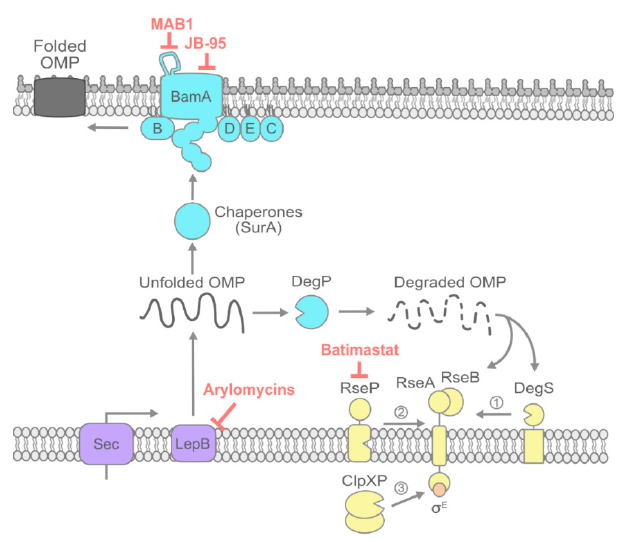
Figure 1. Outer membrane protein (OMP) biogenesis and its inhibitors. Targeted by an N-terminal signal peptide, OMPs are translocated to the inner membrane (IM) via the SecYEG translocon. After translocation, the signal peptide is cleaved by peptidases, such as LepB. Cleavage releases unfolded OMPs (uOMPs) into the periplasm, where they are transported to the outer membrane (OM) by chaperones. The BamABCDE complex receives, folds, and inserts OMPs at the OM. The periplasmic protease DegP degrades uOMPs in the periplasm if they accumulate or misfold. The σ E stress response monitors OMP folding. Degraded uOMPs displace RseB from the anti- σ factor RseA, freeing RseA for cleavage by the protease DegS. Subsequent proteolysis by RseP and ClpXP releases σ E into the cytosol to induce the transcription of stress regulon members. Red labels indicate compounds recently found to be active against steps of OMP biogenesis.